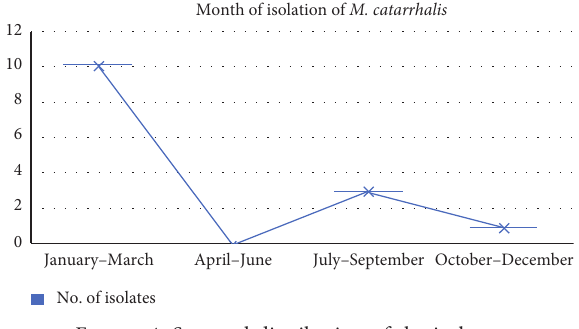
Figure 4: Seasonal distribution of the isolates.